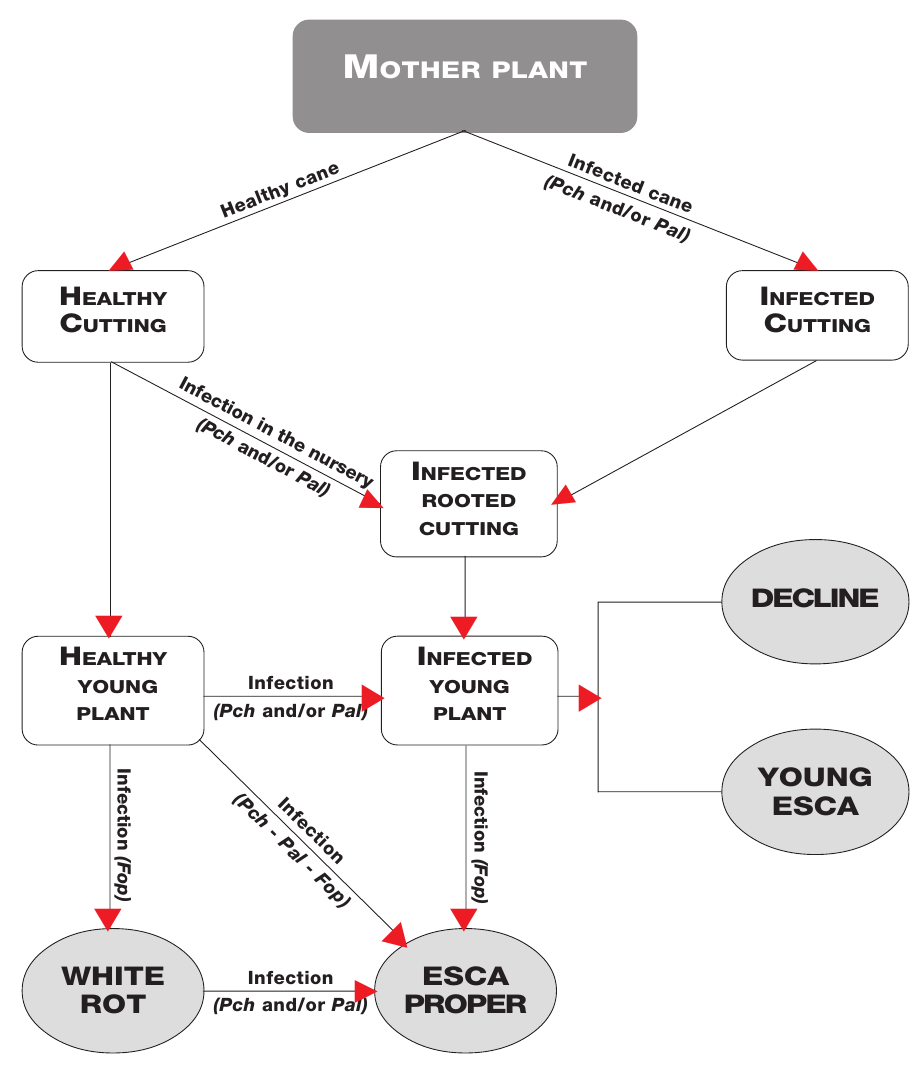
Fig. 1. Proposed scheme of the development of esca and related